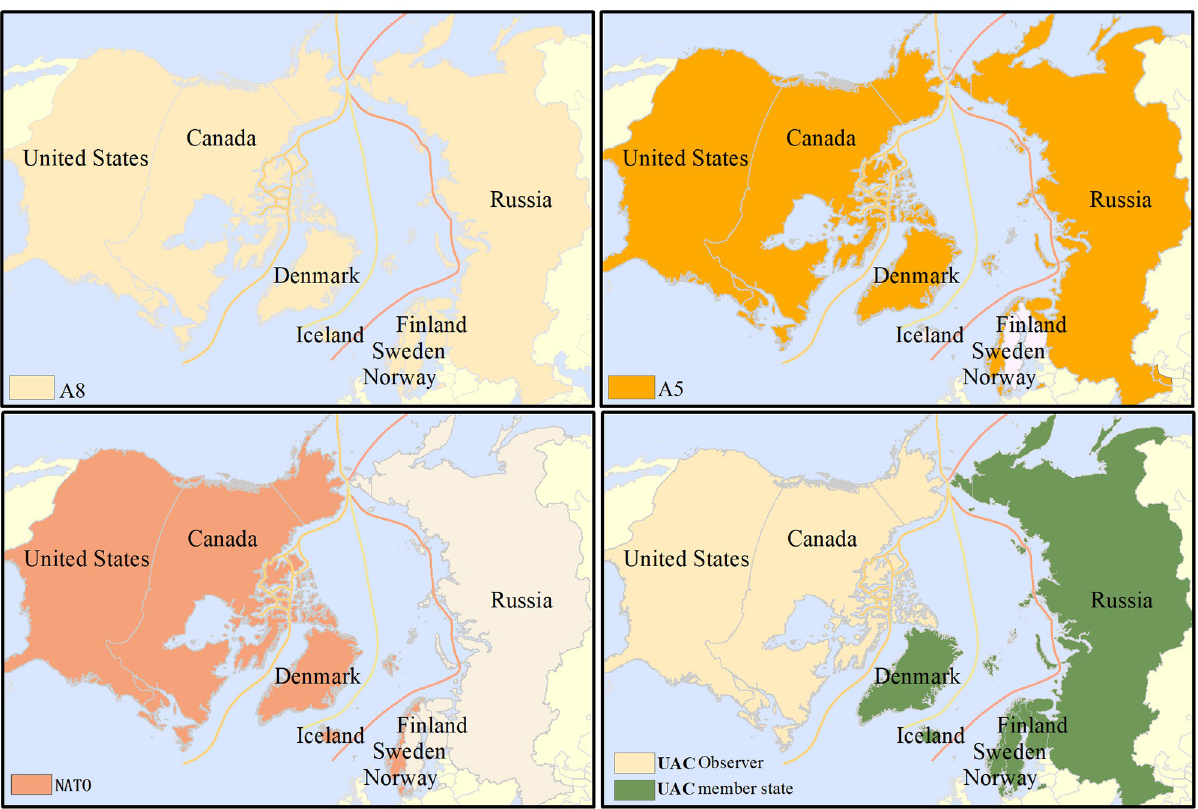
Fig 3. Four examples of geopolitical characteristic extraction and spatial match. The boundary was obtained from Natural Earth (http://www. naturalearthdata.com/).